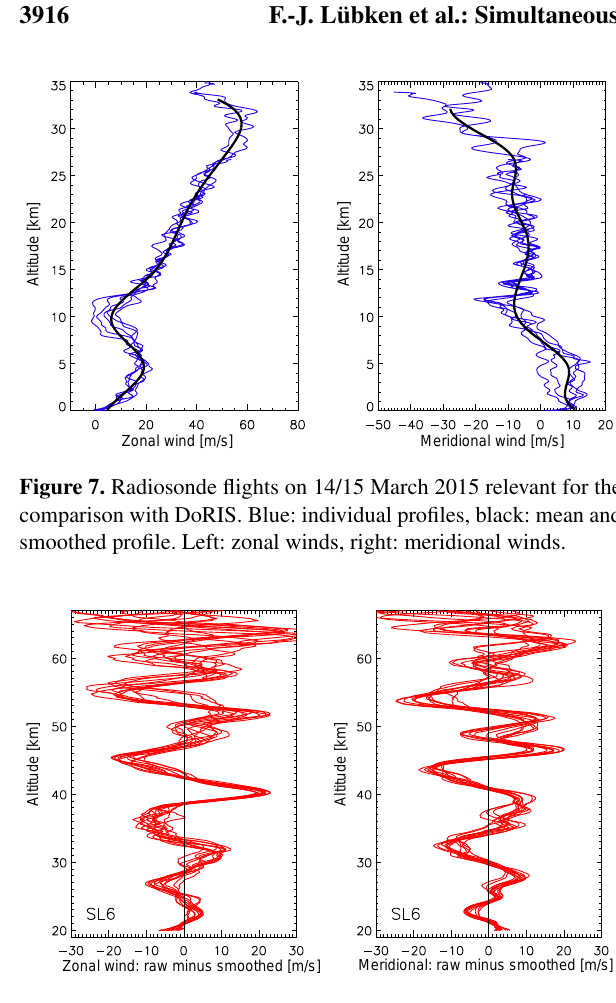
Figure 10. Same as Fig. 9 but for datasonde flight